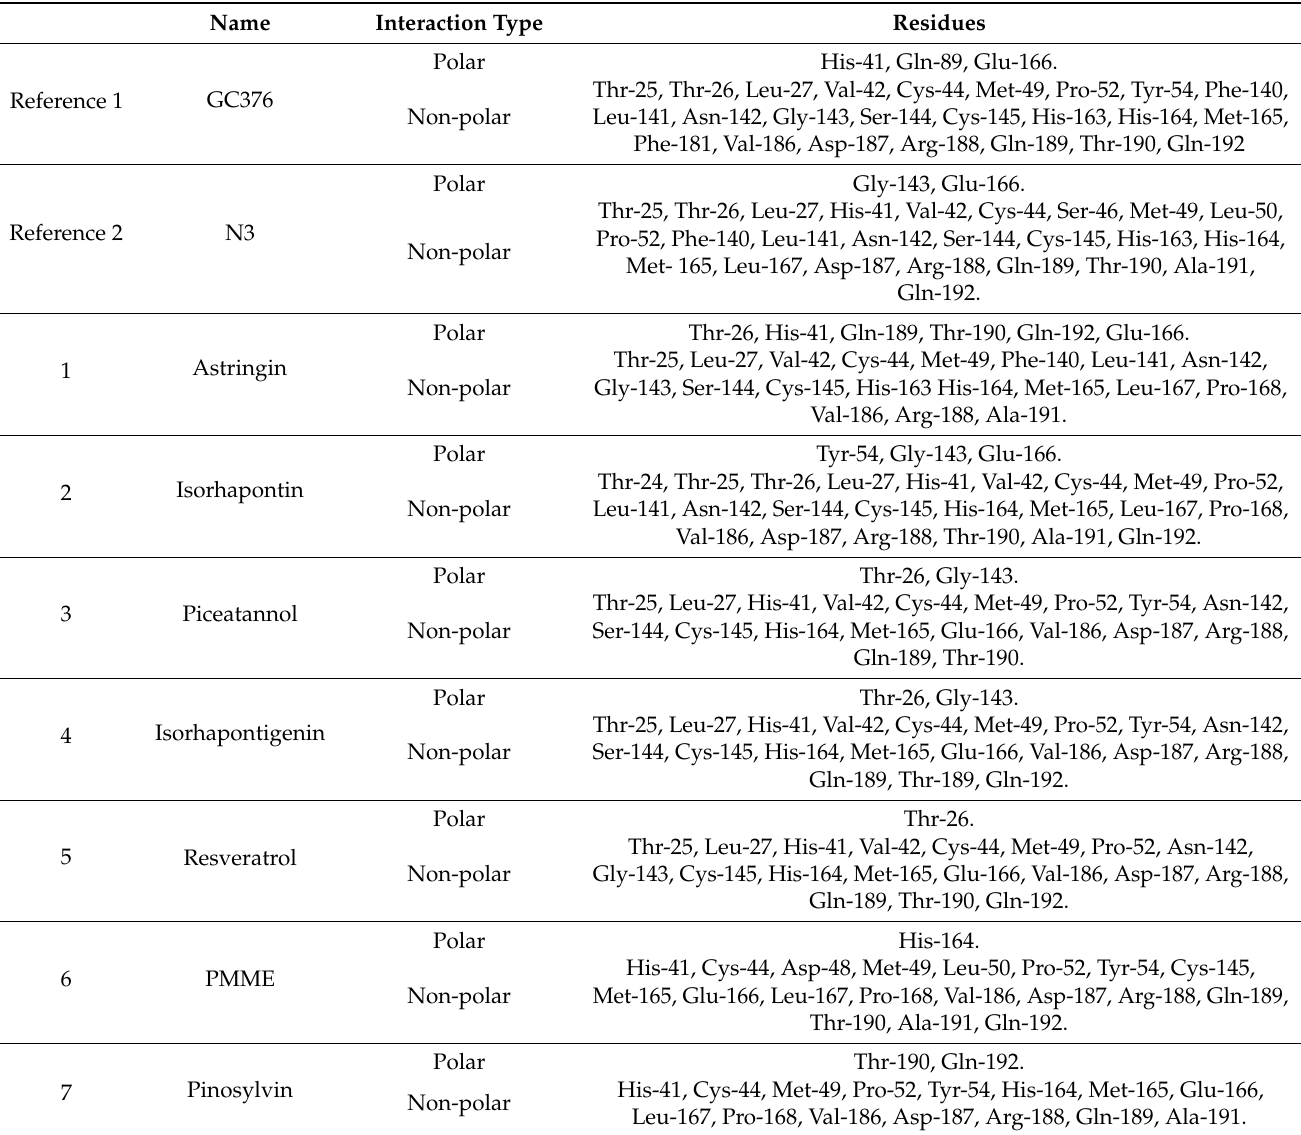
Table 3. Polar and non-polar interactions of the reference and stilbene compounds with amino acids within the M pro binding